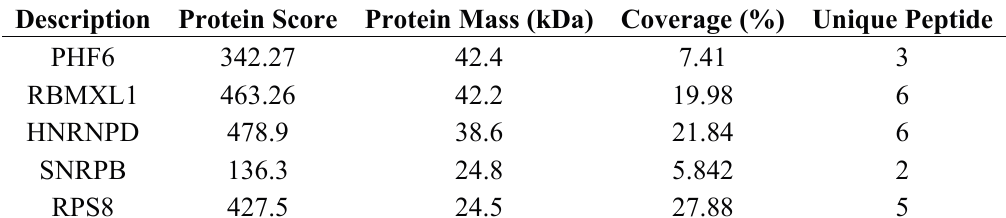
Table 1. Protein identification by mass